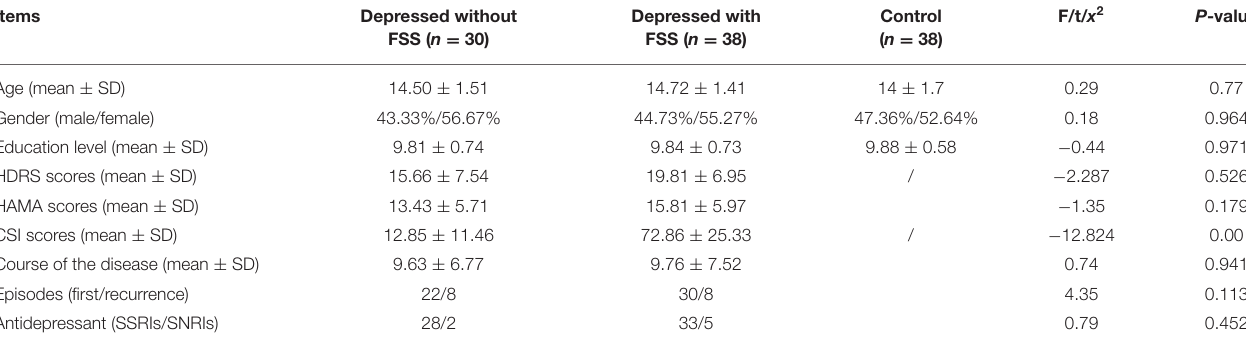
TABLE 1 | Demographic and clinical data of patients and control group.